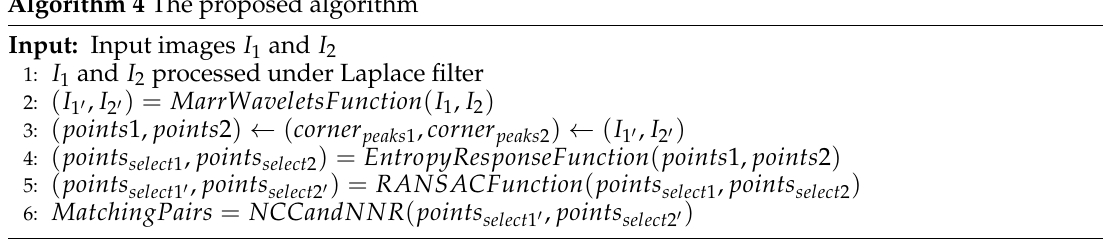
Algorithm 4 The proposed